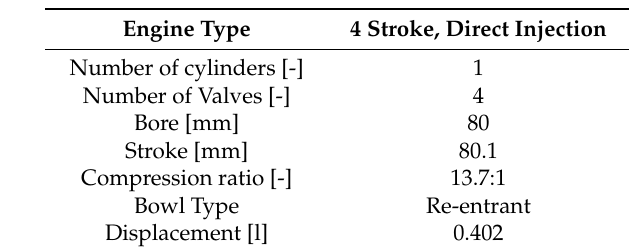
Figure 2. Optical engine. Table 2. Engine